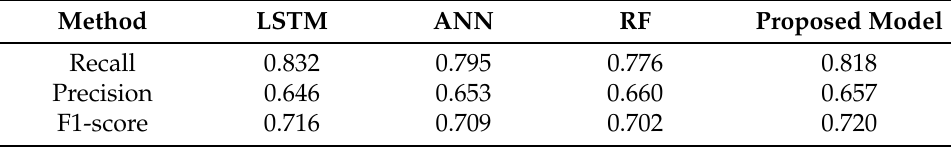
Table 5. Model prediction performances after 5 h at Location